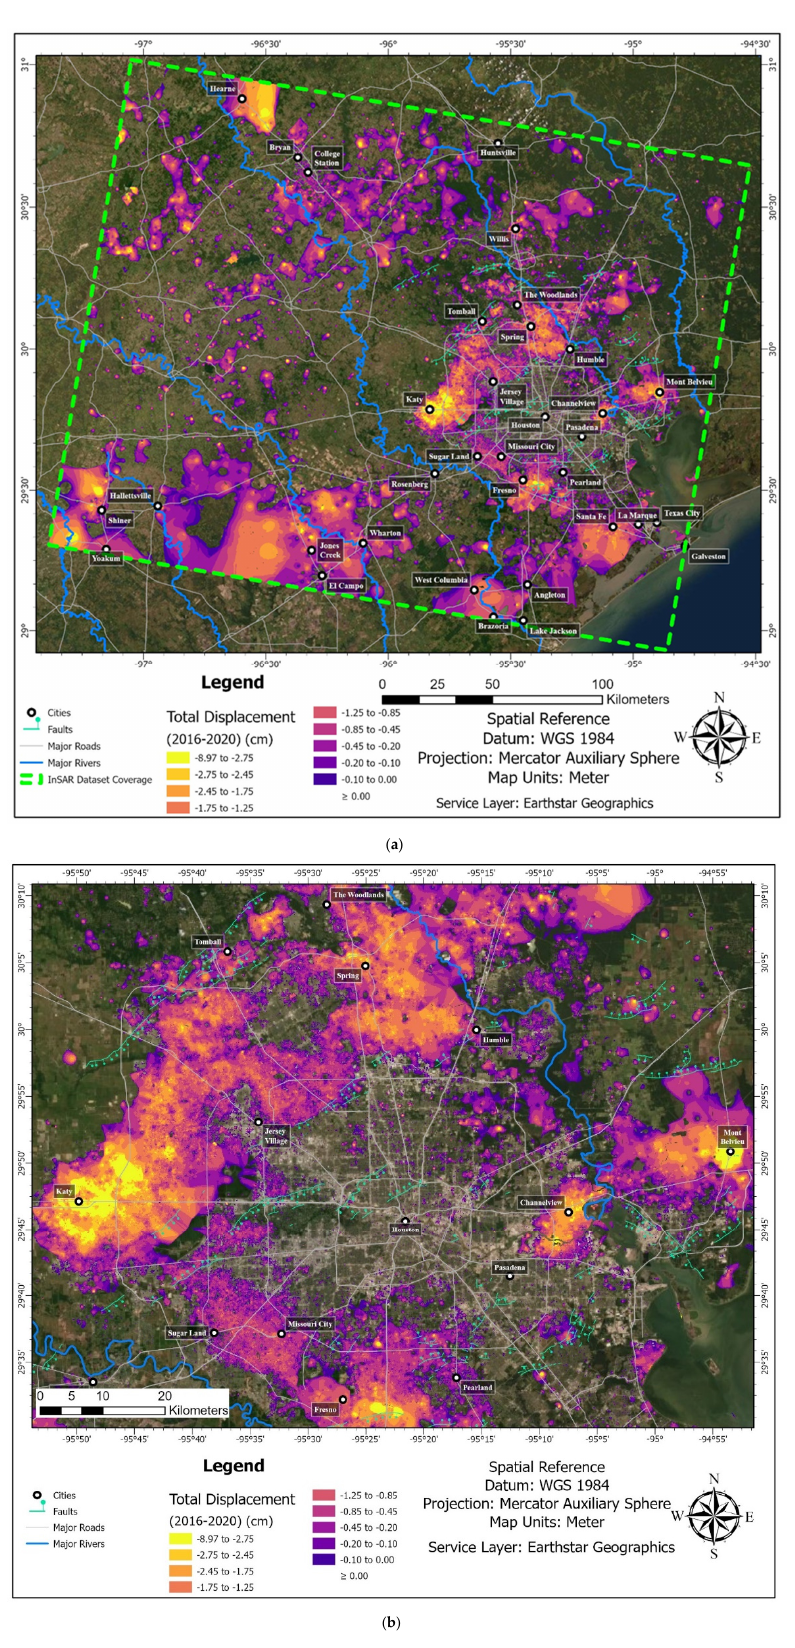
Figure 2. ( a ) Total ground displacement from March 2016 to December 2020 measured by SBAS, InSAR data for Houston and surrounding areas. View of the entire InSAR footprint. ( b ) Zoomed-in view showing downtown Houston and encompassing suburbs and towns.